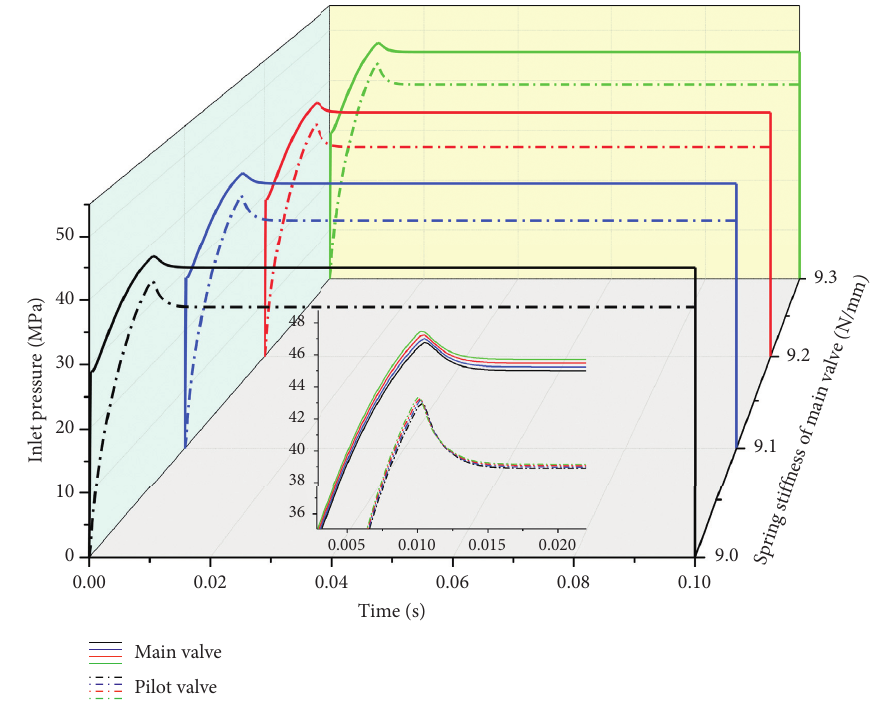
Figure 10: Influence of main valve spring on pressure.